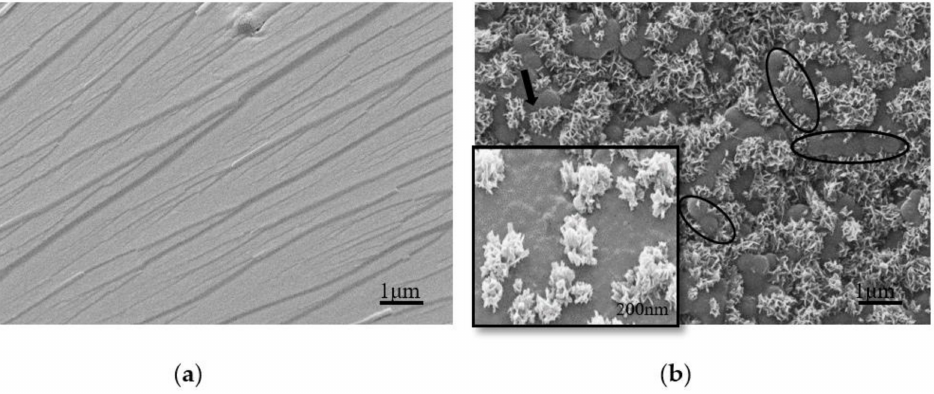
Figure 7. Scanning electron microscope (SEM) comparison of uncured UF resin with different molar ratios. ( a ) F/U = 1.4, there are surface protrusions (arrows) of spherical particles in the section. ( b ) F/U = 1.0, there is an aggregation of spherical particles (ellipse) in the section. The crystal aggregate is composed of a series of crystals of different shapes. The crystals have the form of flat plates with sharp ends on the edges, which can be identified as single crystals (arrows).